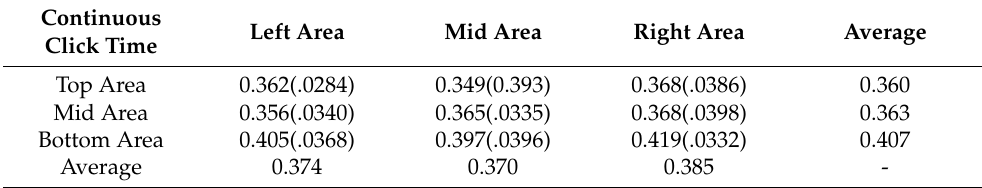
Table 2. Continuous click time